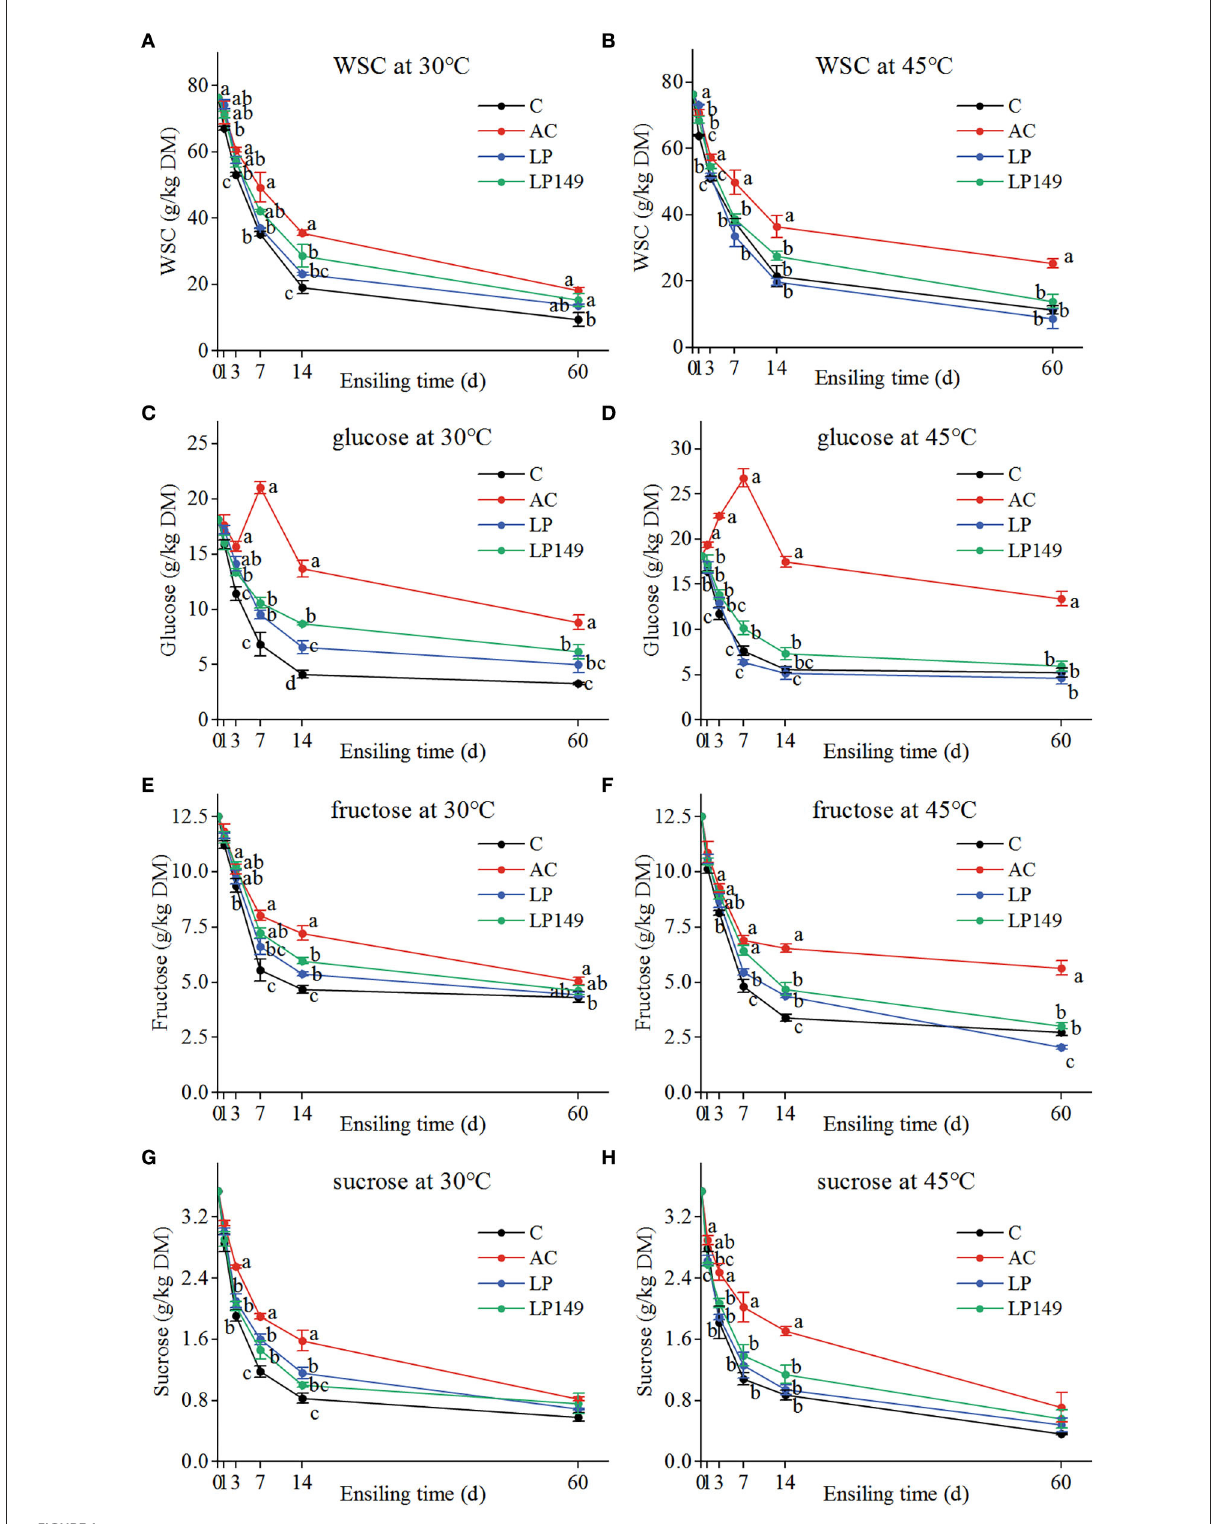
FIGURE1 Variations in the contents of water-soluble carbohydrates (WSC) (A,B) , glucose (C,D) , fructose (E,F) , and sucrose (G,H) of hybrid elephant grass silages treated with additives at different ensiling times and temperatures. C, control; AC, Acremonium cellulase; LP, commercial